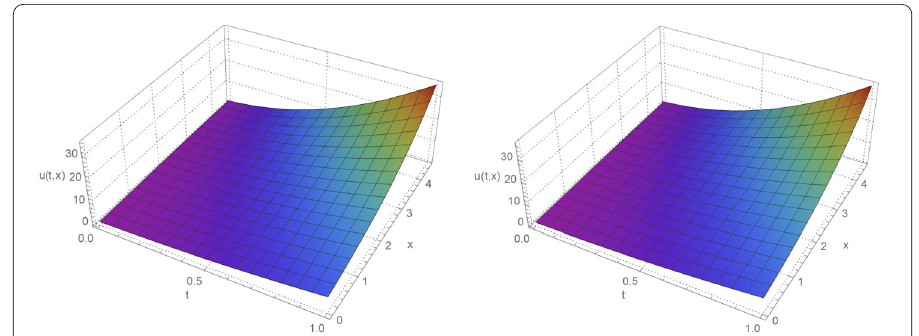
Figure 8 RPSM vs. q-HAM for Case II for U (2) ( t , x ) with β = 0.1, γ = 0.1 and α = 1